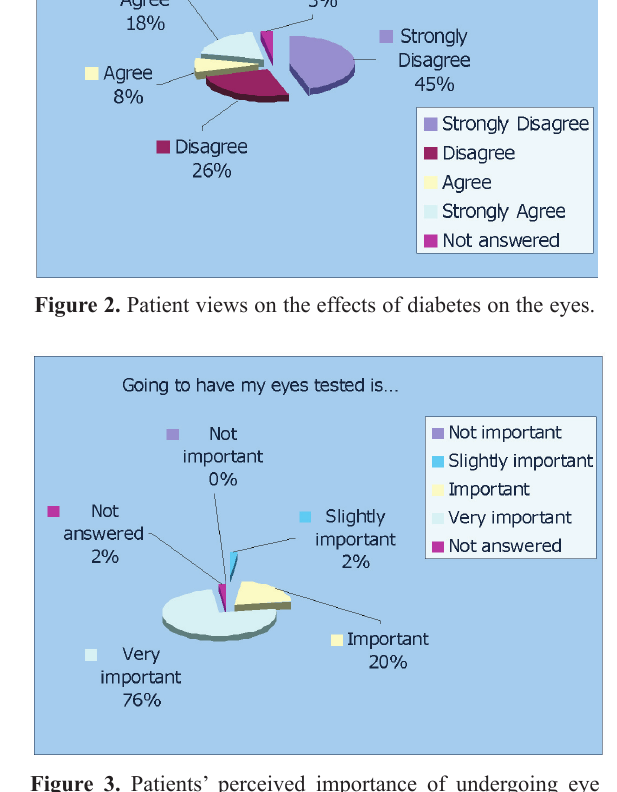
Figure 3. Patients’ perceived importance of undergoing eye